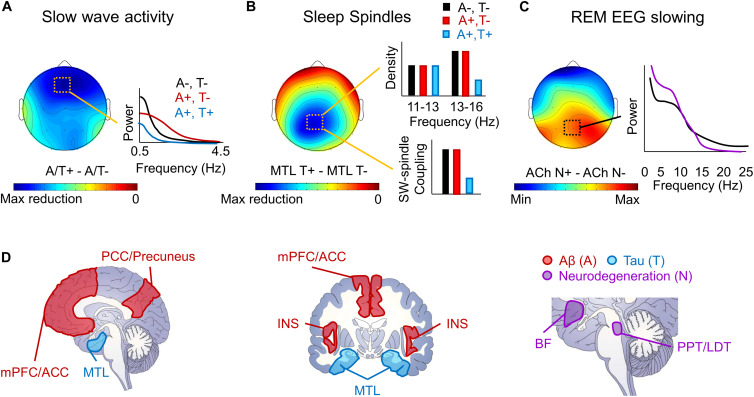
Schematic depiction of local sleep features disrupted by AD pathophysiology. (A) A schematic topoplot of decreases in SWA during NREM sleep in individuals with Aβ (A +, red) and tau (T +, blue) pathology relative to those without pathology (A–, T–, black) is presented, with cooler colors reflecting the severity in the hypothesized reduction in SWA. A schematic of the effects of Aβ and tau pathology on SWA by frequency are plotted to the right. (B) A topoplot of decreases in sleep spindles in individuals with tau pathology, particularly in the medial temporal lobe (MTL) is presented, with cooler colors reflecting the severity of sleep spindle loss in individuals with tau pathology. Schematic bar graphs of the effects of both Aβ (red) and tau (blue) pathology on sleep spindle density and slow wave (SW)-sleep spindle coupling relative to those without AD pathology (black) are presented to the right. (C) A topoplot of the increase in REM sleep EEG slowing in those with cholinergic degeneration (ACh N +, purple) relative to those without significant cholinergic degeneration (ACh N–, black). A schematic frequency by spectral power plot of REM sleep is shown to the right, indicating increased low frequency power and decreased high frequency power in the presence of cholinergic degeneration. (D) Schematic of brain slices depicting the hypothesized locations of Aβ (A, red) and tau (T, blue) deposition, as well as neurodegeneration (N, purple), that lead to the observed local deficits in NREM and REM sleep. mPFC/ACC denotes medial prefrontal cortex and anterior cingulate cortex, PCC/Precuneus denotes posterior cingulate cortex and precuneus, MTL denotes the medial temporal lobe, INS denotes the insula cortex, BF denotes the cholinergic basal forebrain, and PPT/LDT denotes the cholinergic pedunculopontine and lateral dorsal tegmental nuclei.